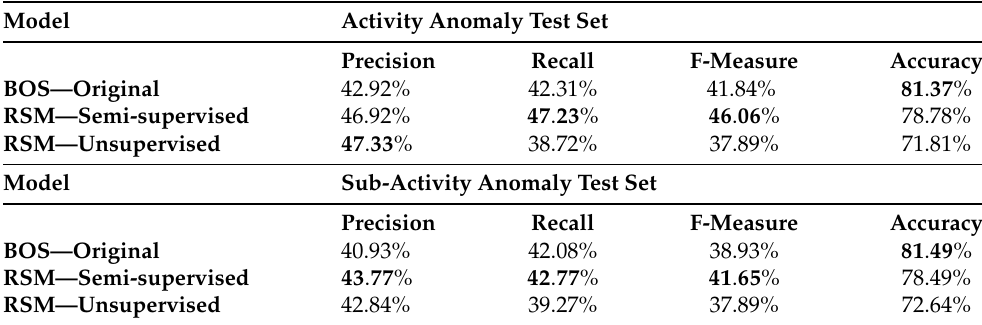
Table 2. J48 classifier precision, recall and accuracy rates (best results presented in bold font) with reconstructed features for both activity and sub-activity-related anomaly test